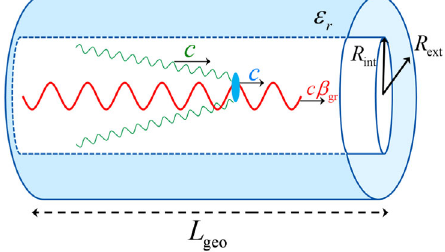
FIG. 1. Schematics of the basic principle and envisaged geometry. Single relativistic microbunches (blue) is accelerated by TM 01 laser mode (red) which propagates at c β velocity, in a vacuum channel of a dielectric ( ε The wake (green), generated by the bunch, propagates at its velocity [22] along the interaction region L